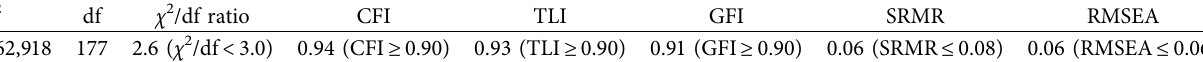
Table 4: Goodness of fit statistics.